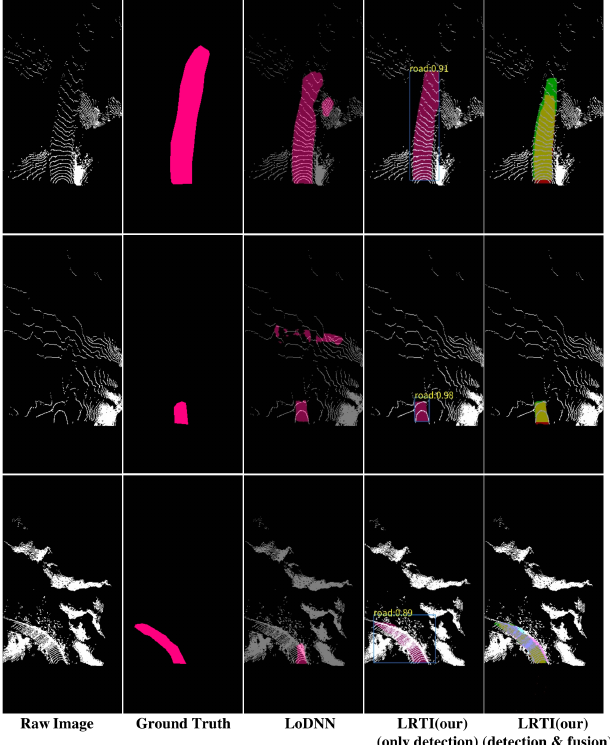
Figure 9. Results of different methods. Each column from left to right represents the model input image, ground truth, LoDNN [43] result, our detection result, and our detection result plus multi- frame